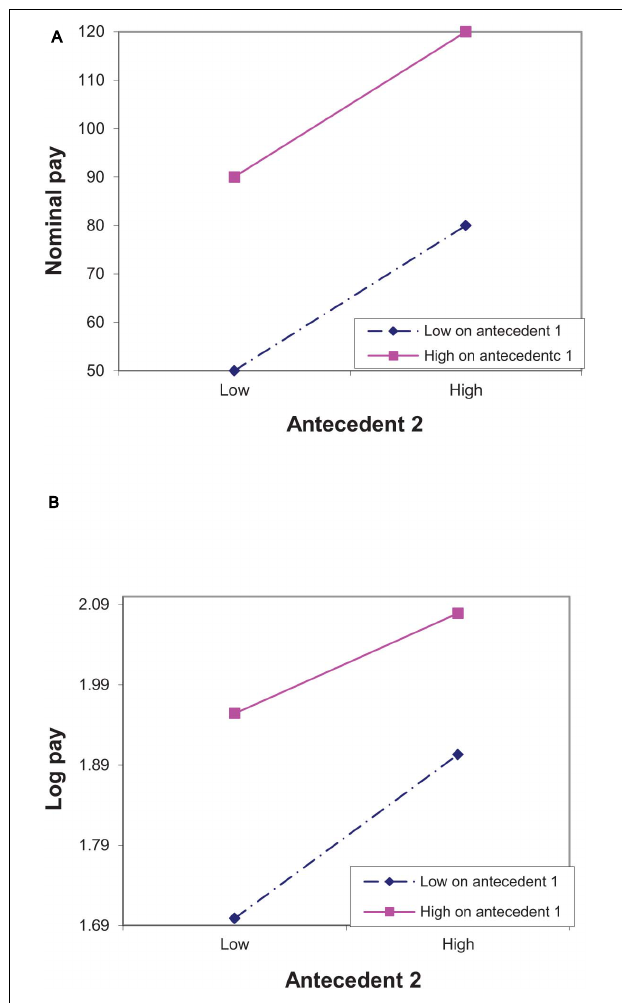
FIGURE 2 | An illustration of Type II error in detecting interactions between two antecedents when the true model of pay is linear. The antecedents can be either two individual characteristics or an individual characteristic and time. In (A) the dependent variable is nominal pay and in (B) it is log pay. The points in (B) are associated with the points in (A) . Thus, for example, log(50) ≈